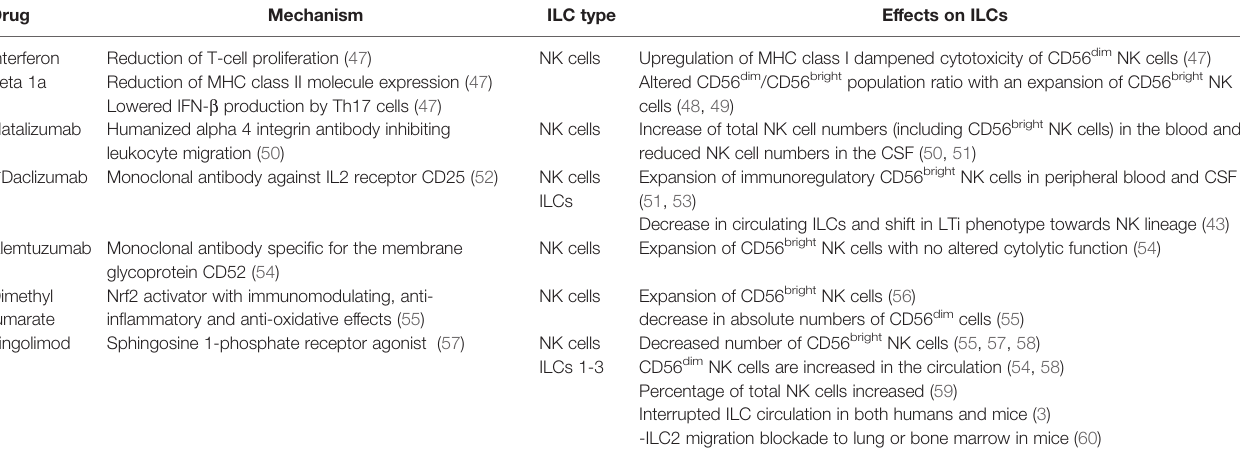
TABLE 2 | Overview of DMTs for MS in fl uencing ILCs.